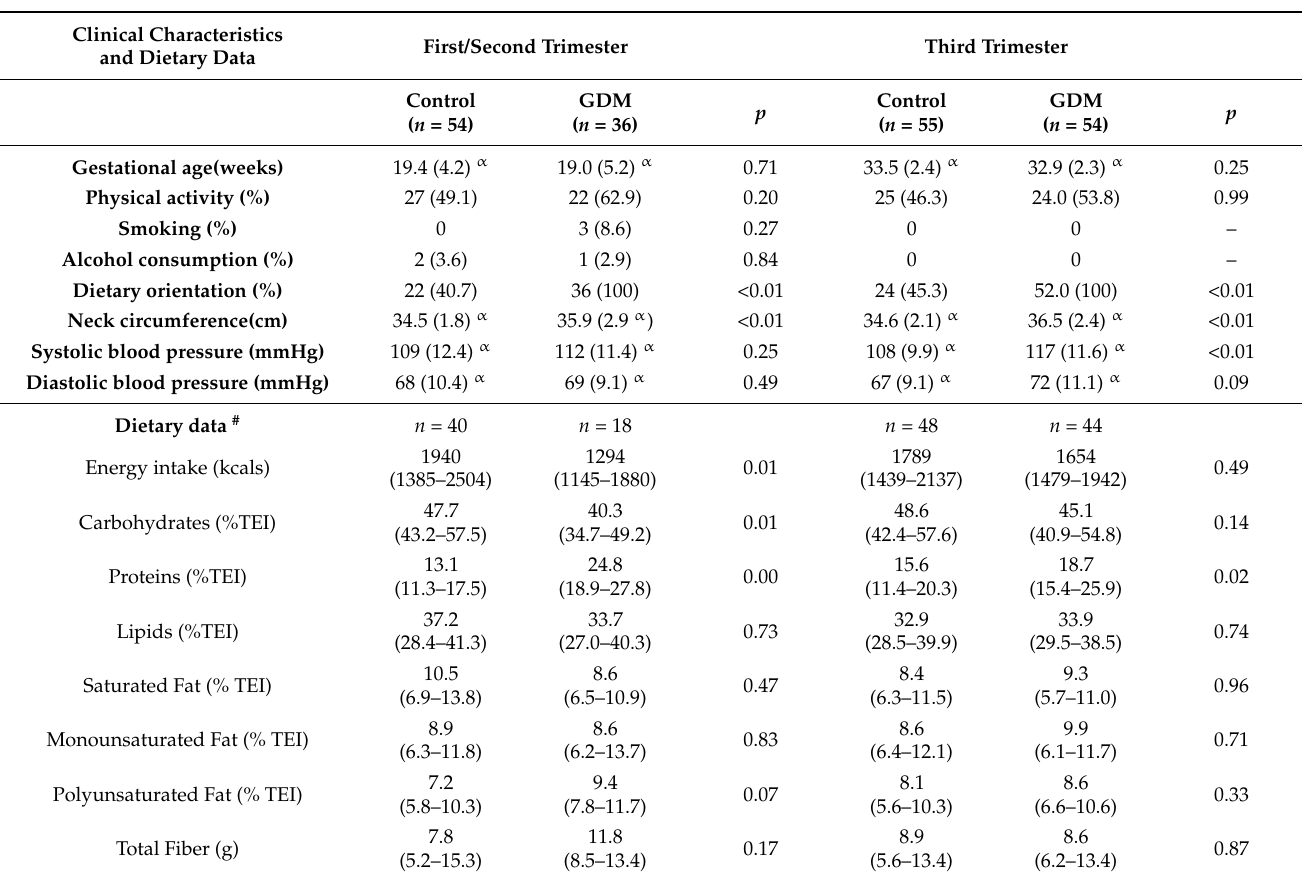
Table 2. Clinical characteristics and behavioral habits of pregnant women with or without GDM during the